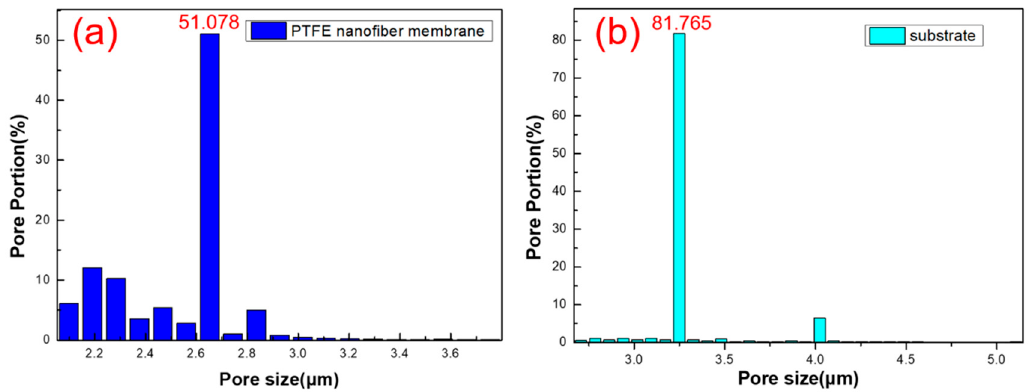
Figure 5. Image of membrane pore size distribution and porosity. ( a ) PTFE nanofiber membrane; ( b ) membrane substrate.